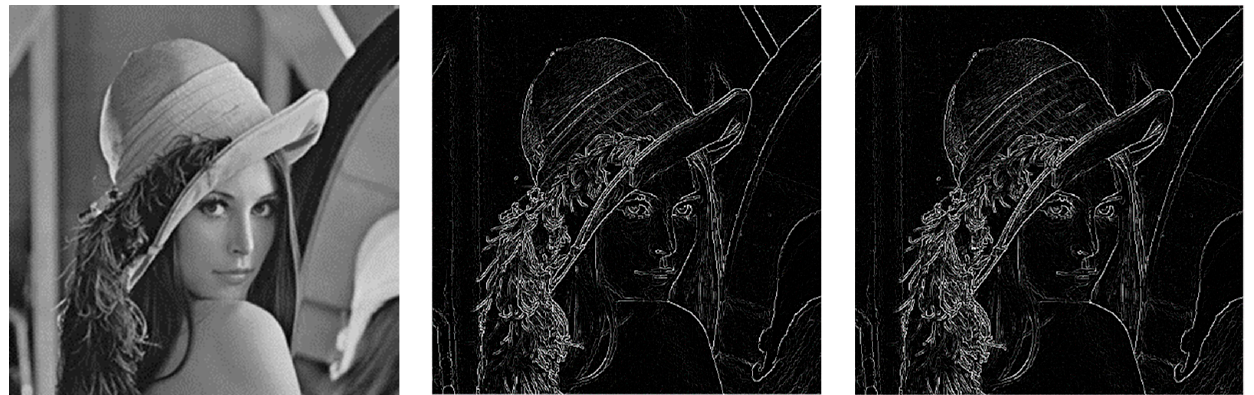
Figure 19. NMS map: Left: original image; Middle: NMS map using Equation (4); Right: NMS map using quantized tanh.